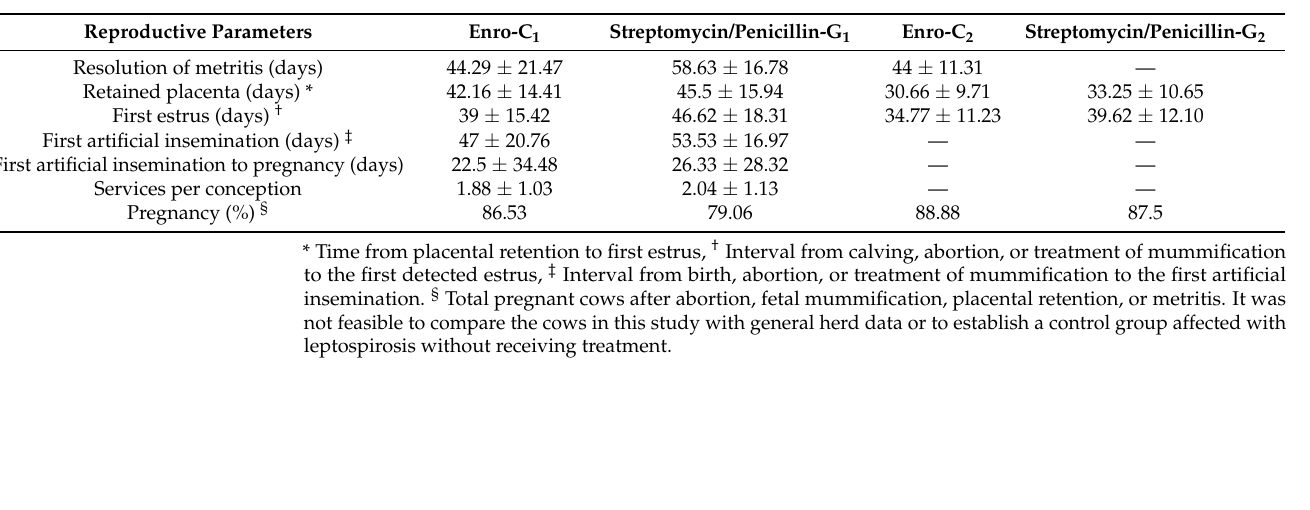
Table 5. Mean ± 1SD values of reproductive parameters observed until day 90 after ending the treatment of cows with leptospirosis with either the IM administration of 15 mg/kg of en- rofloxacin hydrochloride-dihydrate (enro-C) for 5 d or 25 mg/kg of streptomycin/penicillin-G procaine (15,000 IU/kg) for 5 d. Two geographic scenarios in Mexico are presented: the highlands with Holstein/Friesian cows and a tropical area in Mexico with F1 Zebu x Holstein/Friesian